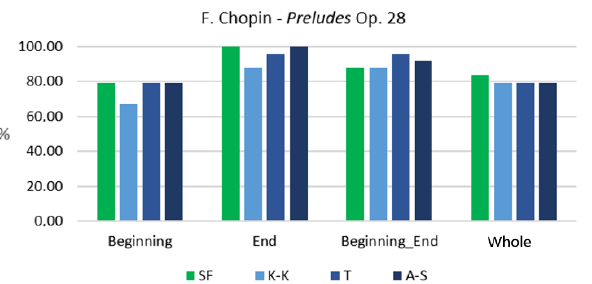
Figure 9. The key-finding efficacies obtained for Preludes Op. 28 by F. Chopin; the analyzed samples represented with the multiplicities of occurrences of individual pitch-classes.